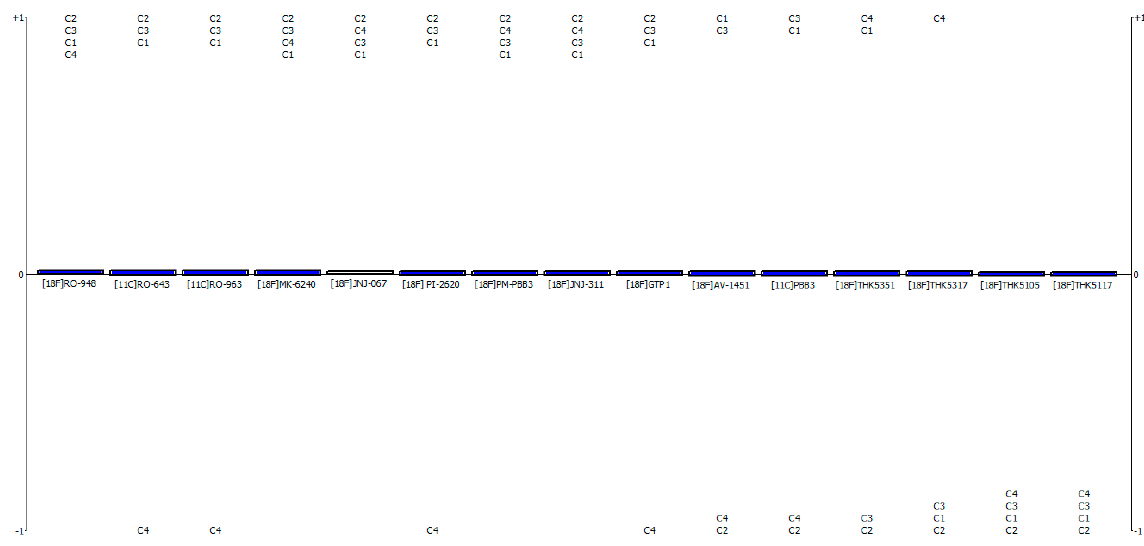
Figure 1. Positive and negative aspects of the alternatives. c1 is specificity, c2 is target binding affinity, c3 is brain uptake and penetration, and c4 is adverse reaction. The criteria that stand on the upper side of the plot are considered positive aspects, while the ones below zero mean that they exhibit undesired properties.